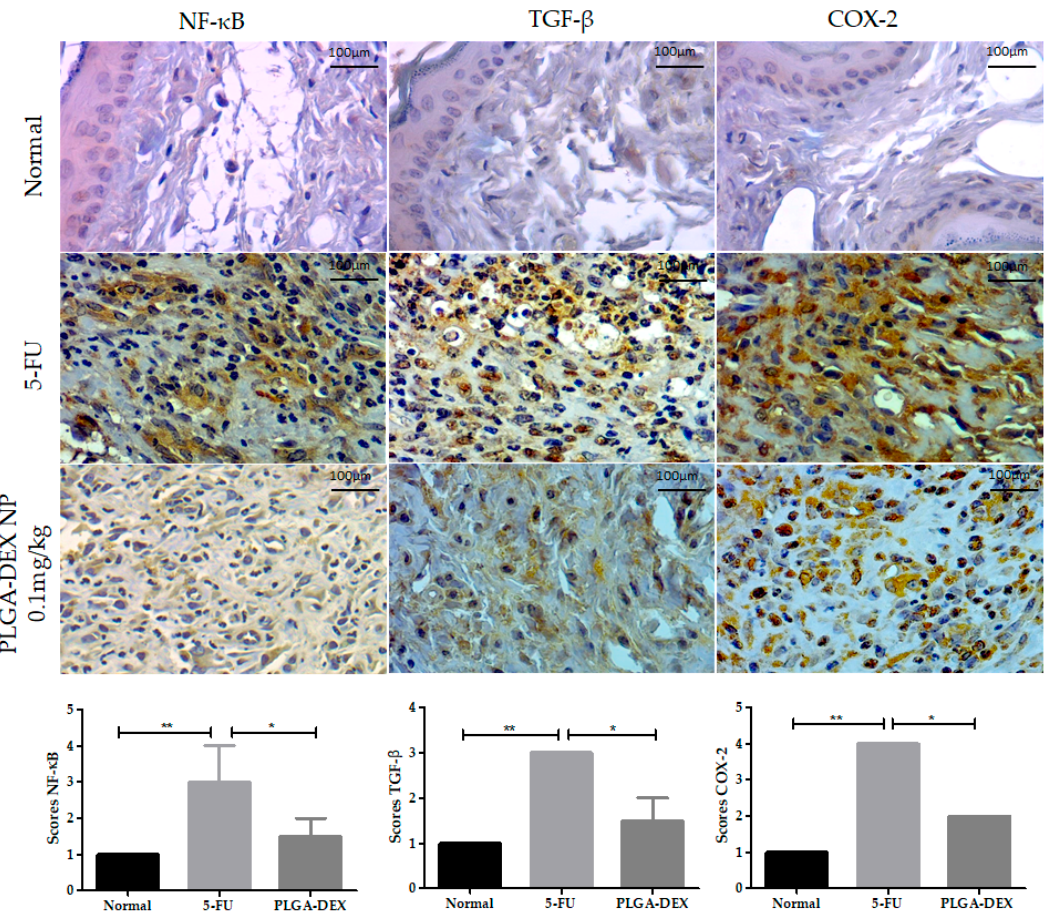
Figure 5. Immunoexpression photomicrographs of NF- κ B, TGF- β , and COX-2 in the normal, 5-FU, and PLGA-DEX 0.1 mg/kg groups. The immunostaining of these proteins was greater in the 5-FU group, while the normal and PLGA-DEX NPs groups exhibited low expression, bars indicating 100 μ m. Expression scores for NF- κ B, TGF- β , and COX-2 with a 95% confidence interval. * p < 0.05; ** p < 0.01 (Kruskal–Wallis test, followed by Dunn’s test for post hoc comparisons).